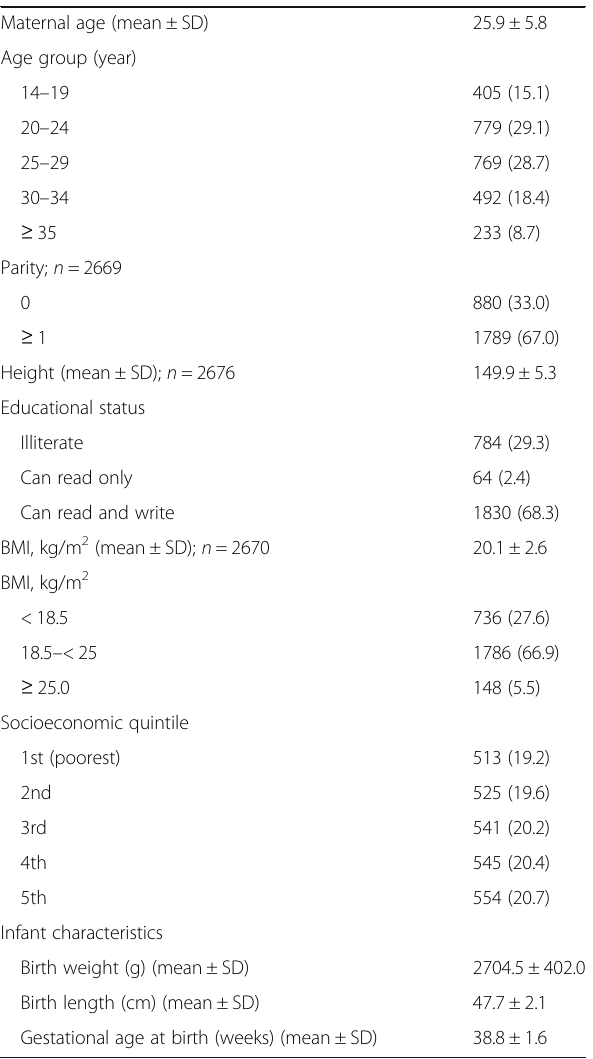
Table 1 Characteristics of study subjects ( n = 2678) Variables